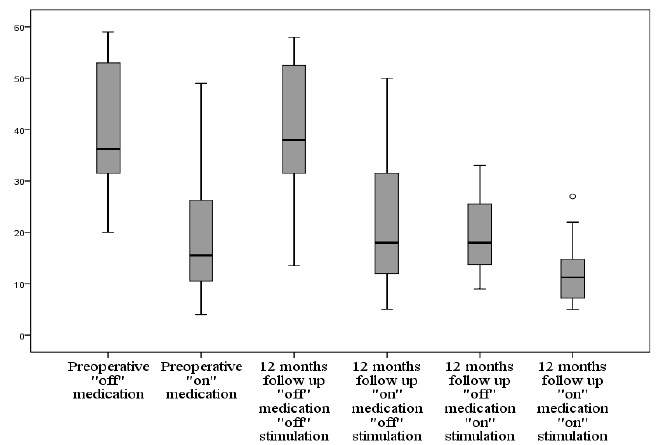
Figure 14. Graph showing the changes of UPDRS III score preoperatively and at 12-month follow-up in different medication and stimulation combinations; UPDRS Unified Parkinson’s Disease Rating Scale.